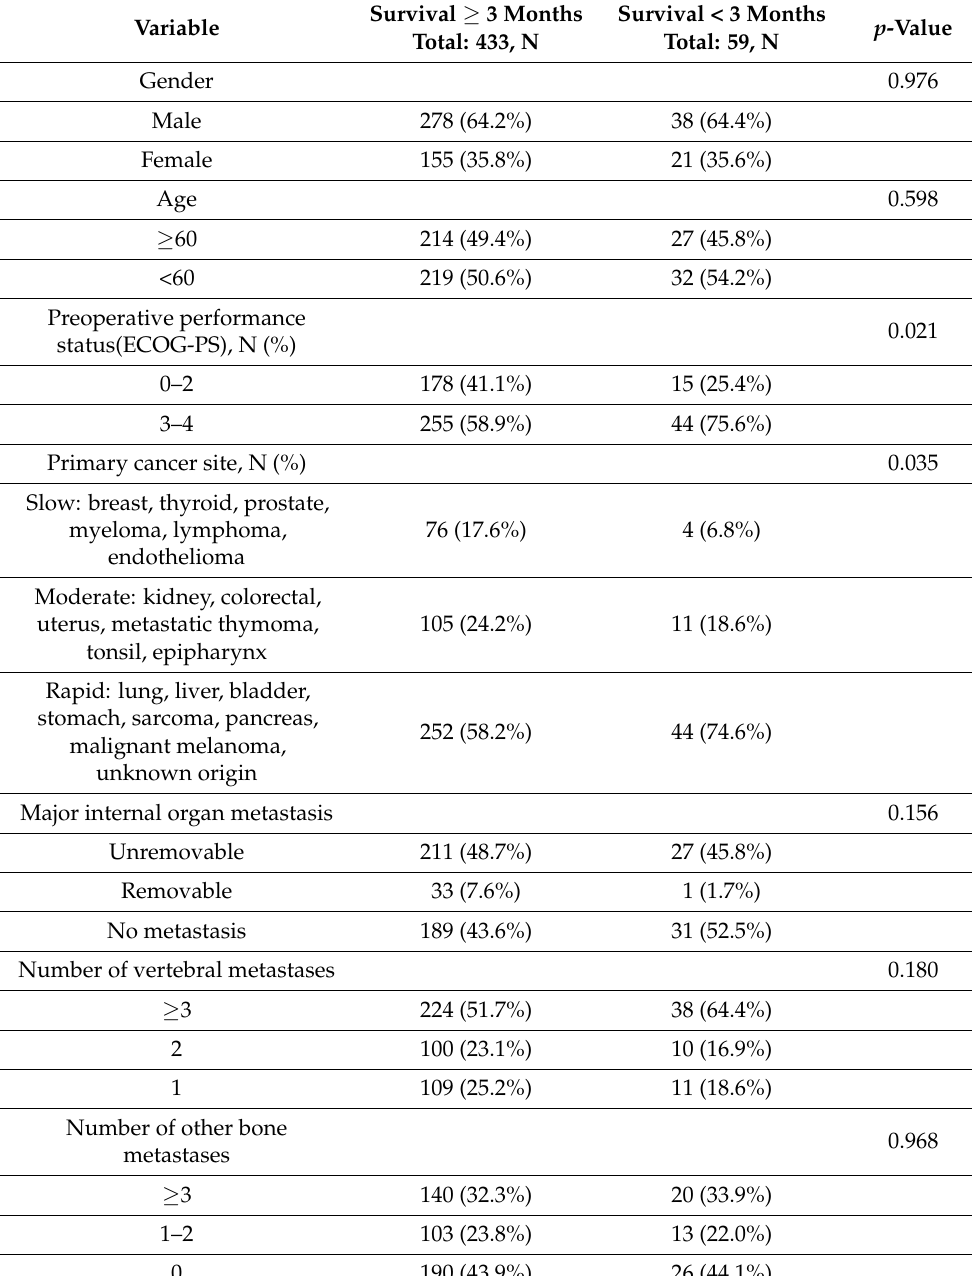
Table 6. Analysis of baseline characteristics based on actual 3-month